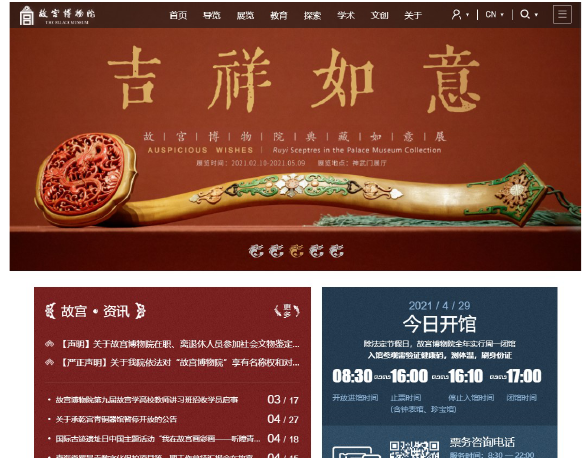
Figure 1. The Palace Museum home page interface .